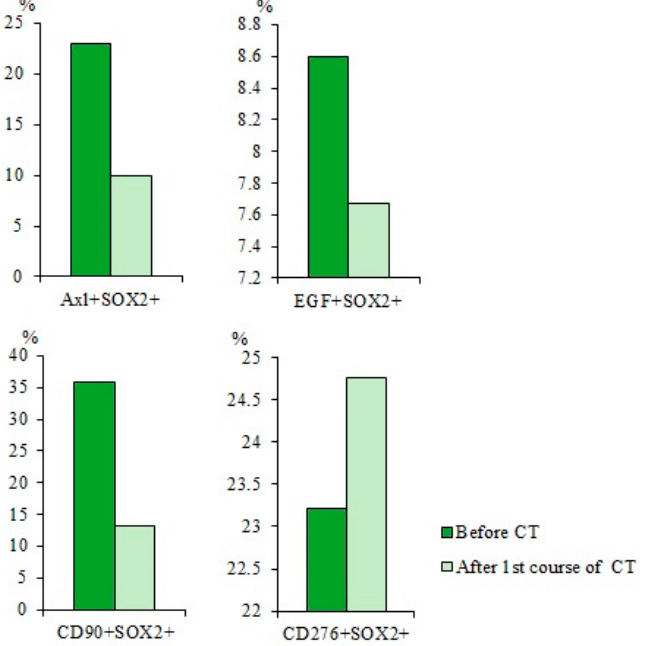
Figure 12. The content of Axl + SOX2 + , EGF + SOX2 + , CD87 + SOX2 + , CD276 + SOX2 + , and CD90 + SOX2 + circulating tumor cells (CTCs) isolated from the blood of SCLC patients G (% of all labelled mononuclear cells). Cells were analyzed by flow cytometry using antibodies against Axl, EGF, CD87, CD276, CD90, and SOX2. Cells were analyzed by flow cytometry using antibodies for CD87, CD90, CD276, EGF, Axl, and SOX2. 2.7.4. Differences in the Effect of Cytostatics on CD3 + CD8 + T-Lymphocytes of Patient G were Revealed Relative to the General Group of Patients with SCLC CT increased the total population of CD3 + CD8 + T-lymphocytes (by 20%) in the blood of patient G relative to those before treatment. At the same time, there was an increase in the number of T-lymphocytes with phenotypes CD3 + CD8 + CD69 + (by 67%), CD3 + CD8 + CD69 + EGF + (by 25.5%), and CD3 + CD8 + CD69 + Axl + (by 49%) (Figure 13). However, the number of CD3 + CD8 + EGF + T-lymphocytes decreased significantly (by 85.5%). Changes in CD3 + CD8 + Ki67 + T-lymphocytes and CD3 + CD8 + CD69 + Ki67 + T- lymphocytes were not significant.